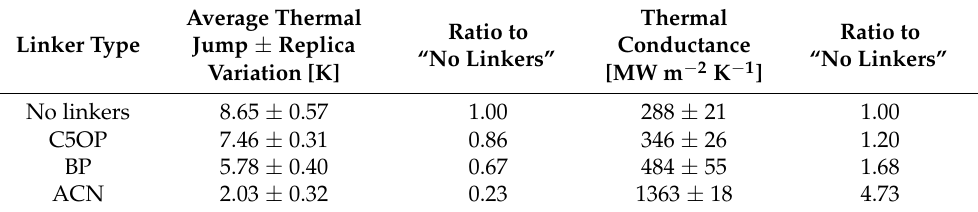
Table 2. Thermal jump, thermal jump reduction, thermal conductance and thermal conductance change, for all the systems